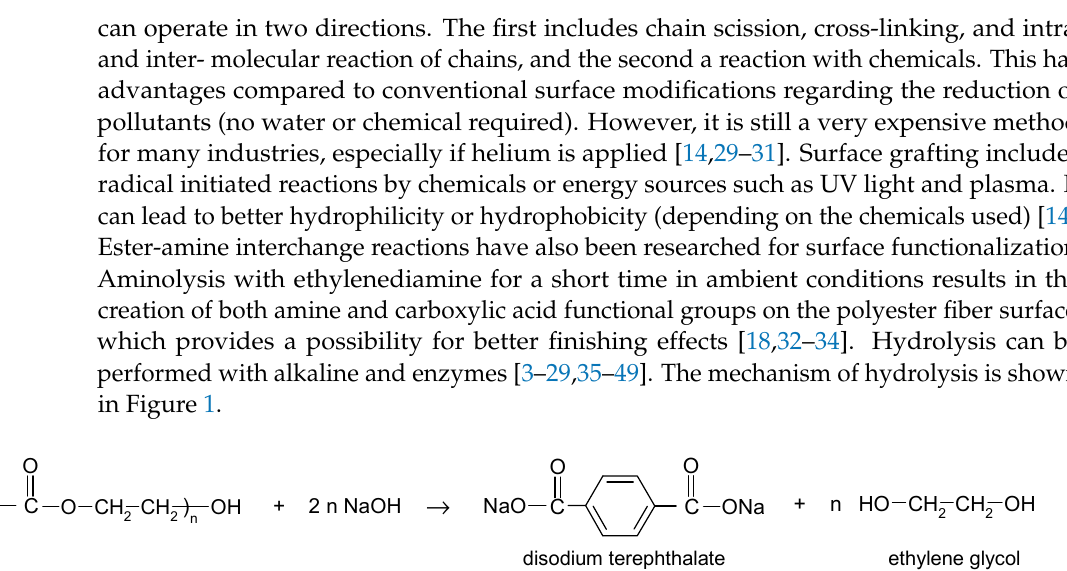
Figure 1. PET Figure 1. PET hydrolysis.